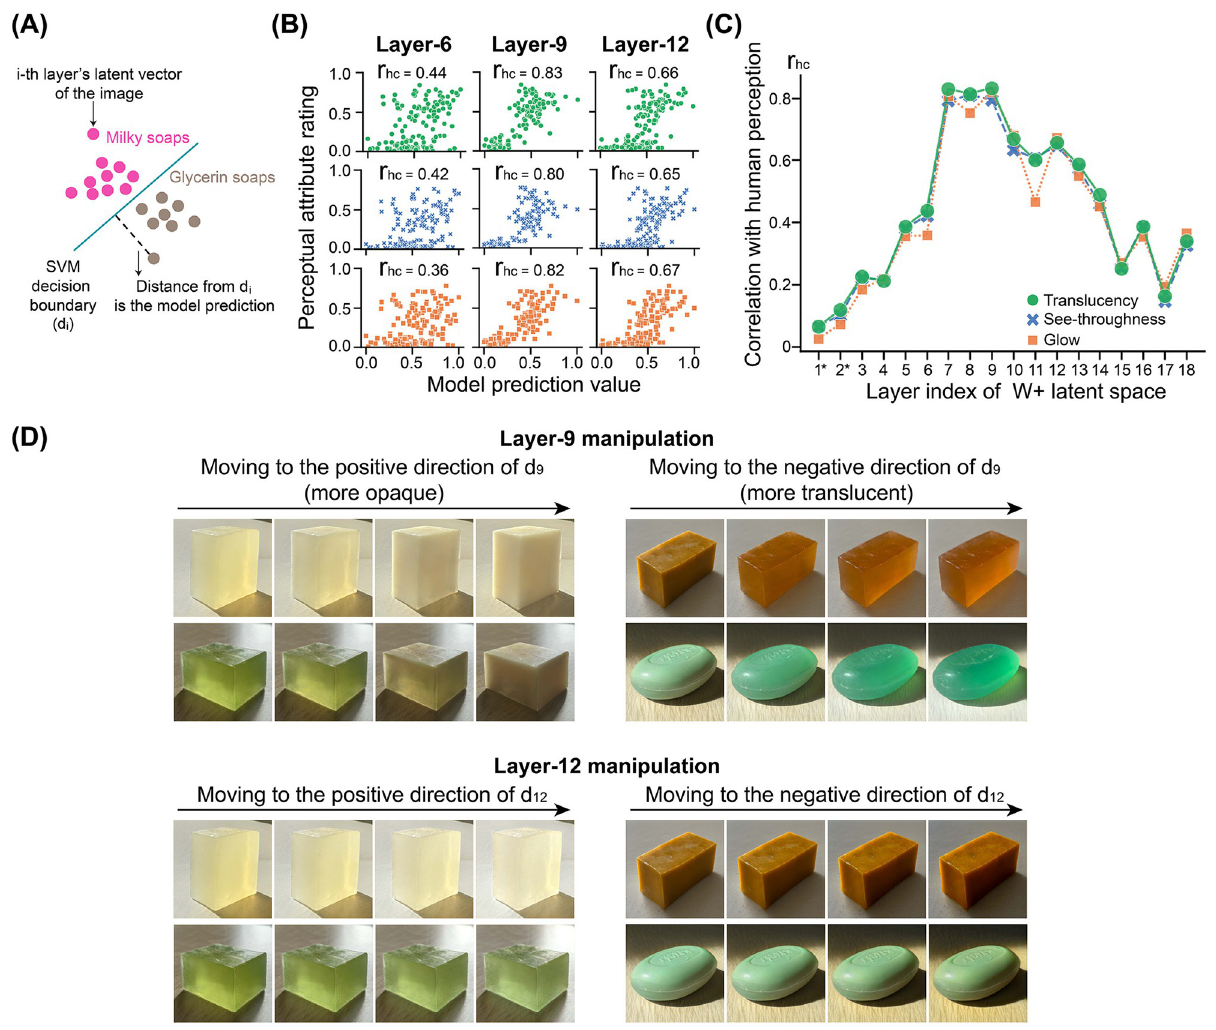
Fig 5. The middle-layers of W + latent space can effectively modulate translucency of generated images and predict human perception. (A) Illustration of a trained layer-specific supported vector machine (SVM) classifier for the milky-versus-glycerin soap discrimination. (B) The scatter plots show the model prediction values versus the human mean normalized attribute ratings for each generated image in Experiment 2. Green, blue, and orange colors represent the data for translucency, see-throughness, and glow, respectively. (C) The tuning curve of correlation coefficients (correlation between model prediction and human perceptual rating, r hc ) over all layers in the W + latent space. Model prediction values using the middle-layers’ decision boundaries ( d 7 , d 8 , and d 9 ) strongly correlate with human attribute ratings. “ � ” indicates the correlations at that layer are statistically insignificant at the 95% confidence level. (D) Examples of translucency-modulated sequences. Top: Manipulating the layer-9 latent vector of the original image (left end) along the normal of the learned decision boundary has a coherent effect on the translucent material appearance of the object. Left: Moving to the positive direction of the normal of the decision boundary makes the soap appear more opaque. Right: Moving to the negative direction of the normal of the decision boundary makes the soap appear more translucent. Bottom: Manipulating the layer-12 latent vector of the original image along the normal of the learned decision boundary does not fundamentally change the translucent